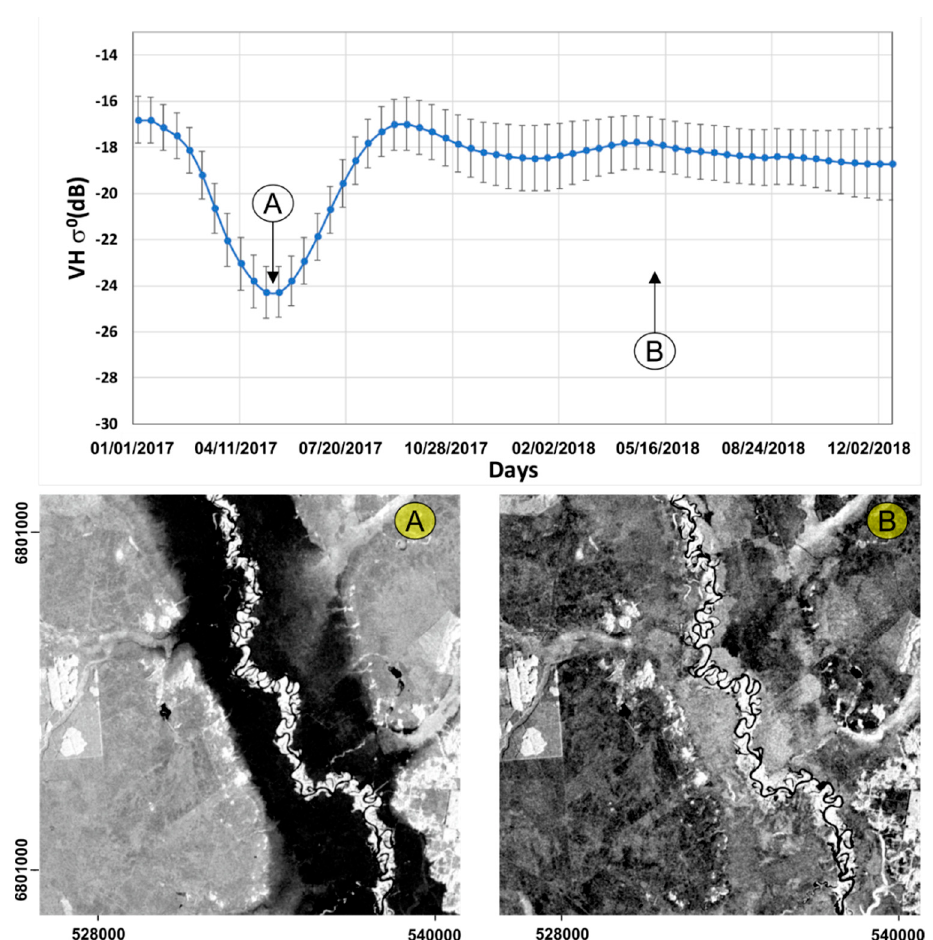
Figure 13. Behavior of the mean time series with the respective standard deviation bars for grassland regions in floodplain, southern Brazil. Sentinel-1 images in the VH polarization representing: (A) flood period, and (B) dry period.